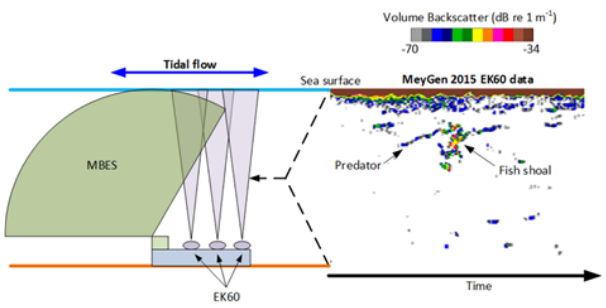
Fig. 3. Multi-sensor seabed platforms that combine multi-frequency echosounders and multibeam echosounders such as FLOWBEC allow measurement of animal presence and behaviour, including predator- prey foraging interactions as shown. Figure adapted from the techniques of [20],[21] using unpublished data from the MeyGen tidal stream site, Scotland.